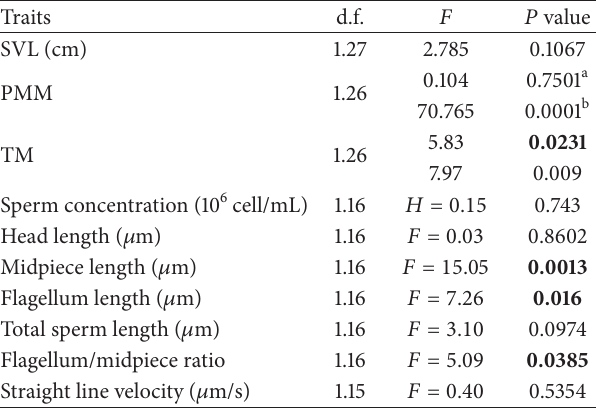
Table 3: Comparison between species in